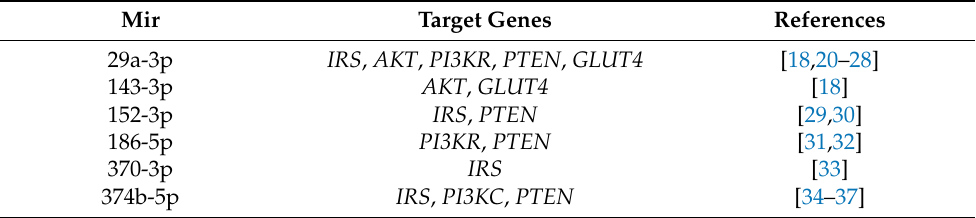
Table 1. Analyzed miRs associated with their target genes of insulin